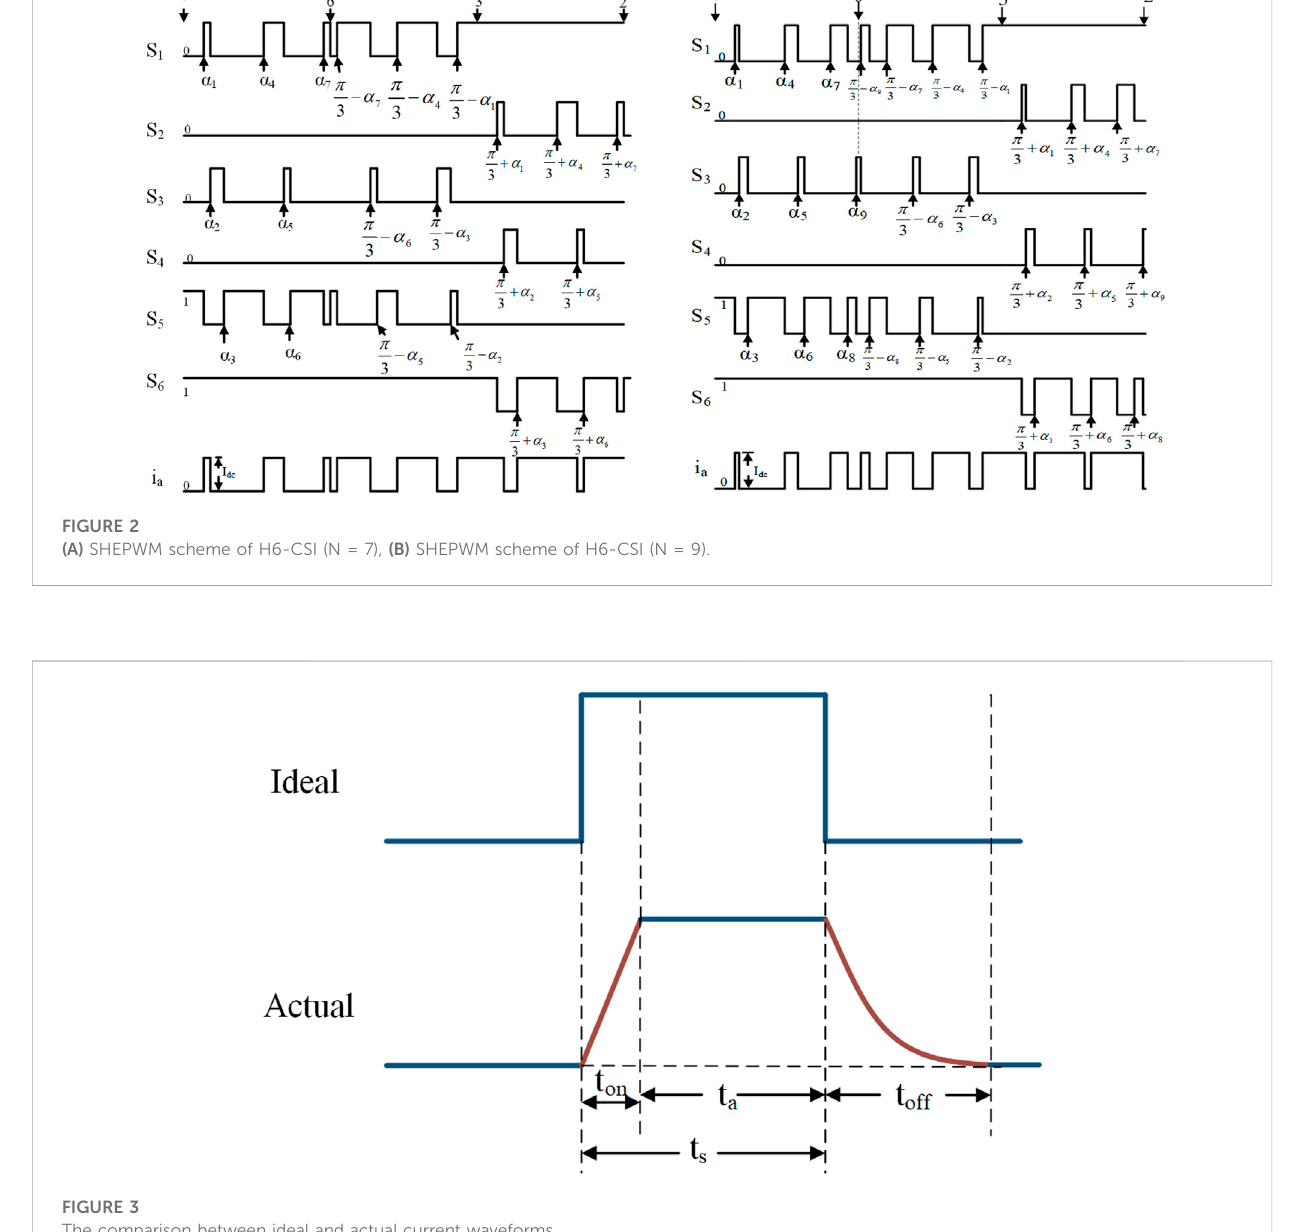
The comparison between ideal and actual current